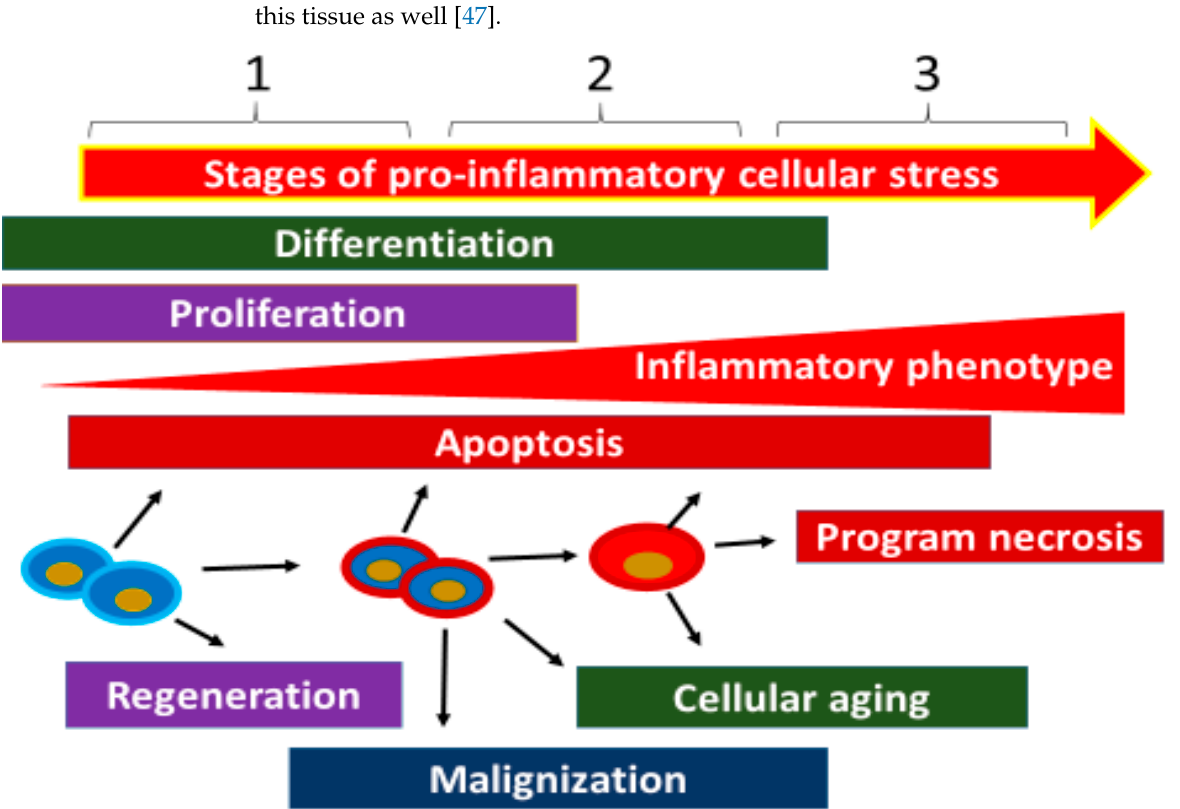
Figure 4. Three stages of cellular stress development. Stage 1 is typical for proliferating cells; it is characterized by the predominance of growth factors in the secretory phenotype; relatively moder- ate manifestations of pro-inflammatory phenotype (including oxidative stress); dominance of ana- bolic processes; and adaptation to the moderate action of damaging factors. This stage can be com- plicated by the processes of tissue metaplasia and malignization. At the level of tissue stress, this stage is also typical for many physiological and pathology borderline processes, as well as for the repair (regenerative) stage of inflammation. Stage 2 is a transitional stage; it is characterized by dif- ferent proportions between the first and third stages. Stage 3 is characterized by more pronounced manifestations of the pro-inflammatory phenotype in response to the increasing effect of damaging factors; increasing insulin resistance; cell cycle blockade; accelerated cell aging; an increasing role of autophagy and mitochondrial stress; and a high probability of programmed necrosis in the variant of pyroptosis, NETosis, and necrobiosis. When microvessels and migrating leukocytes are involved in these processes, conditions emerge for the formation of a canonical inflammation focus or for the development of systemic microcirculatory disorders as signs of systemic inflammation.